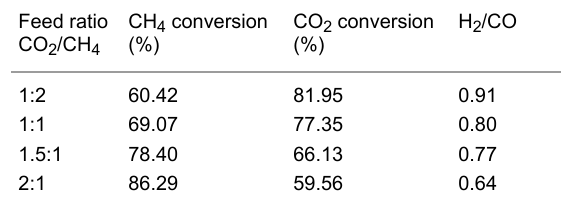
Table 6: Influence of feed ratio on the activity of a 10 wt % Ni/MgO catalyst in the DRM reaction at 700 °C and gas hourly space velocity (GHSV) of 1.8 × 10 4 mL/h·g cat